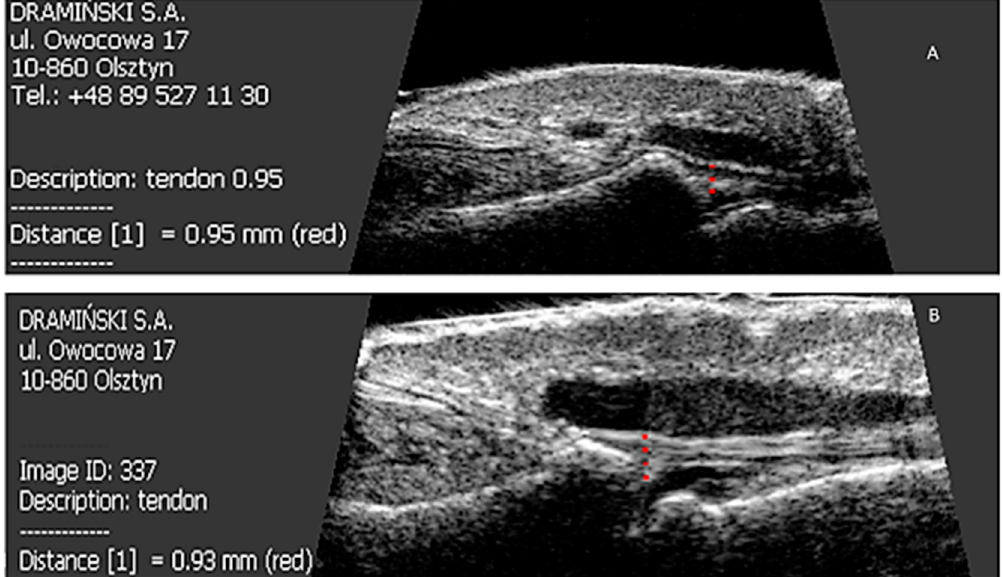
Figure 4. Effect of six months of methotrexate treatment on the thickness of the finger extensor tendon in the distal interphalangeal joint in patients studied. ( A ) Before treatment; ( B ) after six months of therapy. Table 4. US measurements of the fingers in patients with psoriasis.